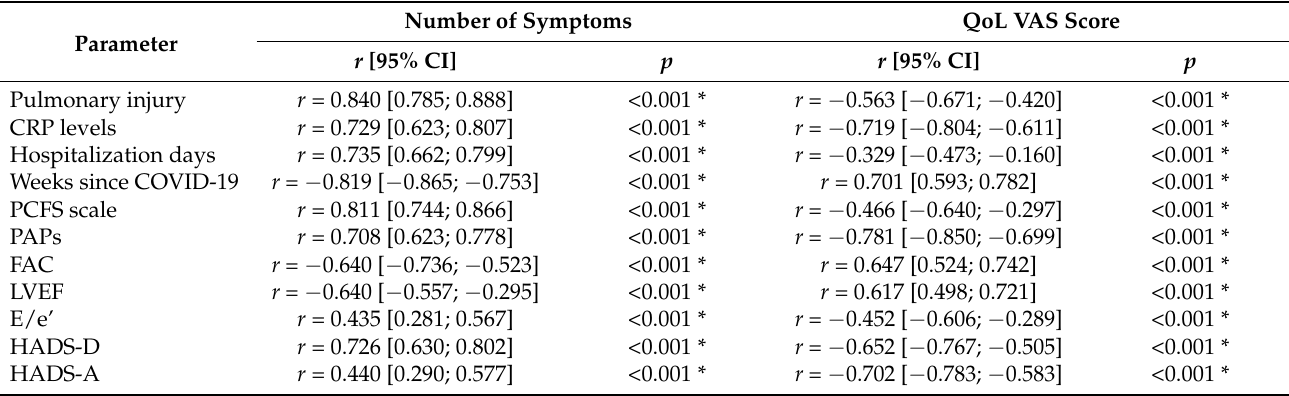
Table 2. Correlations between the number of persisting symptoms and quality of life scores with characteristics of the acute illness, echocardiographic and mental health parameters.